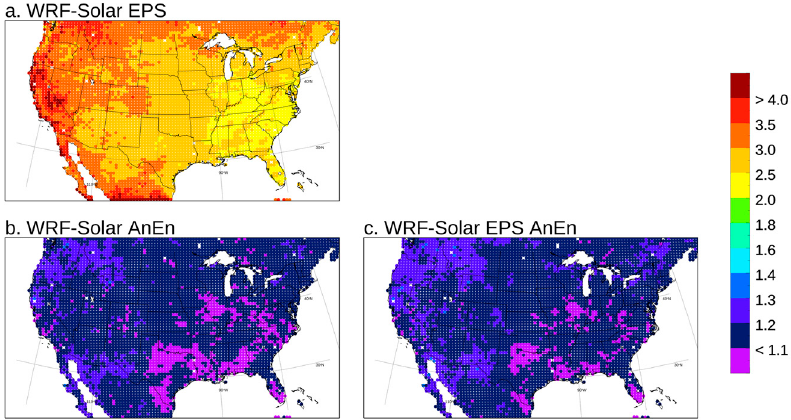
Figure A3. Pearson correlation computed for DNI over the year 2018 for the forecast lead times from +24 to +48 h. The value in the legend at the bottom of each panel indicates the correlation computed by pooling all the grid points and lead times together.